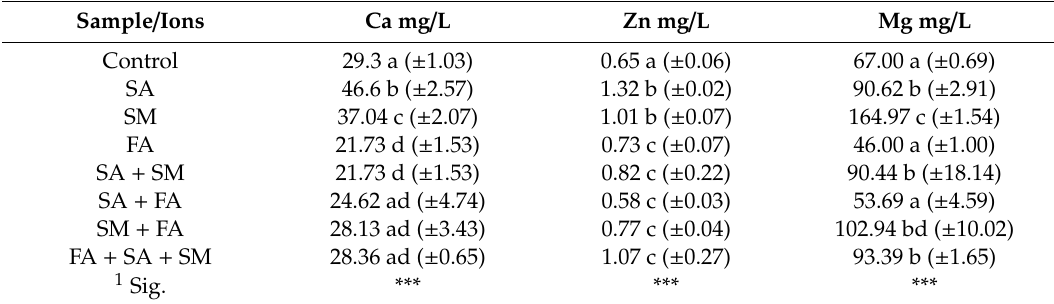
Table 1. The content of selected ions in ciders fermented by wine yeast (W), with the following additions: SA—ammonium sulfate, SM—magnesium sulfate, FA—ammonium phosphate.